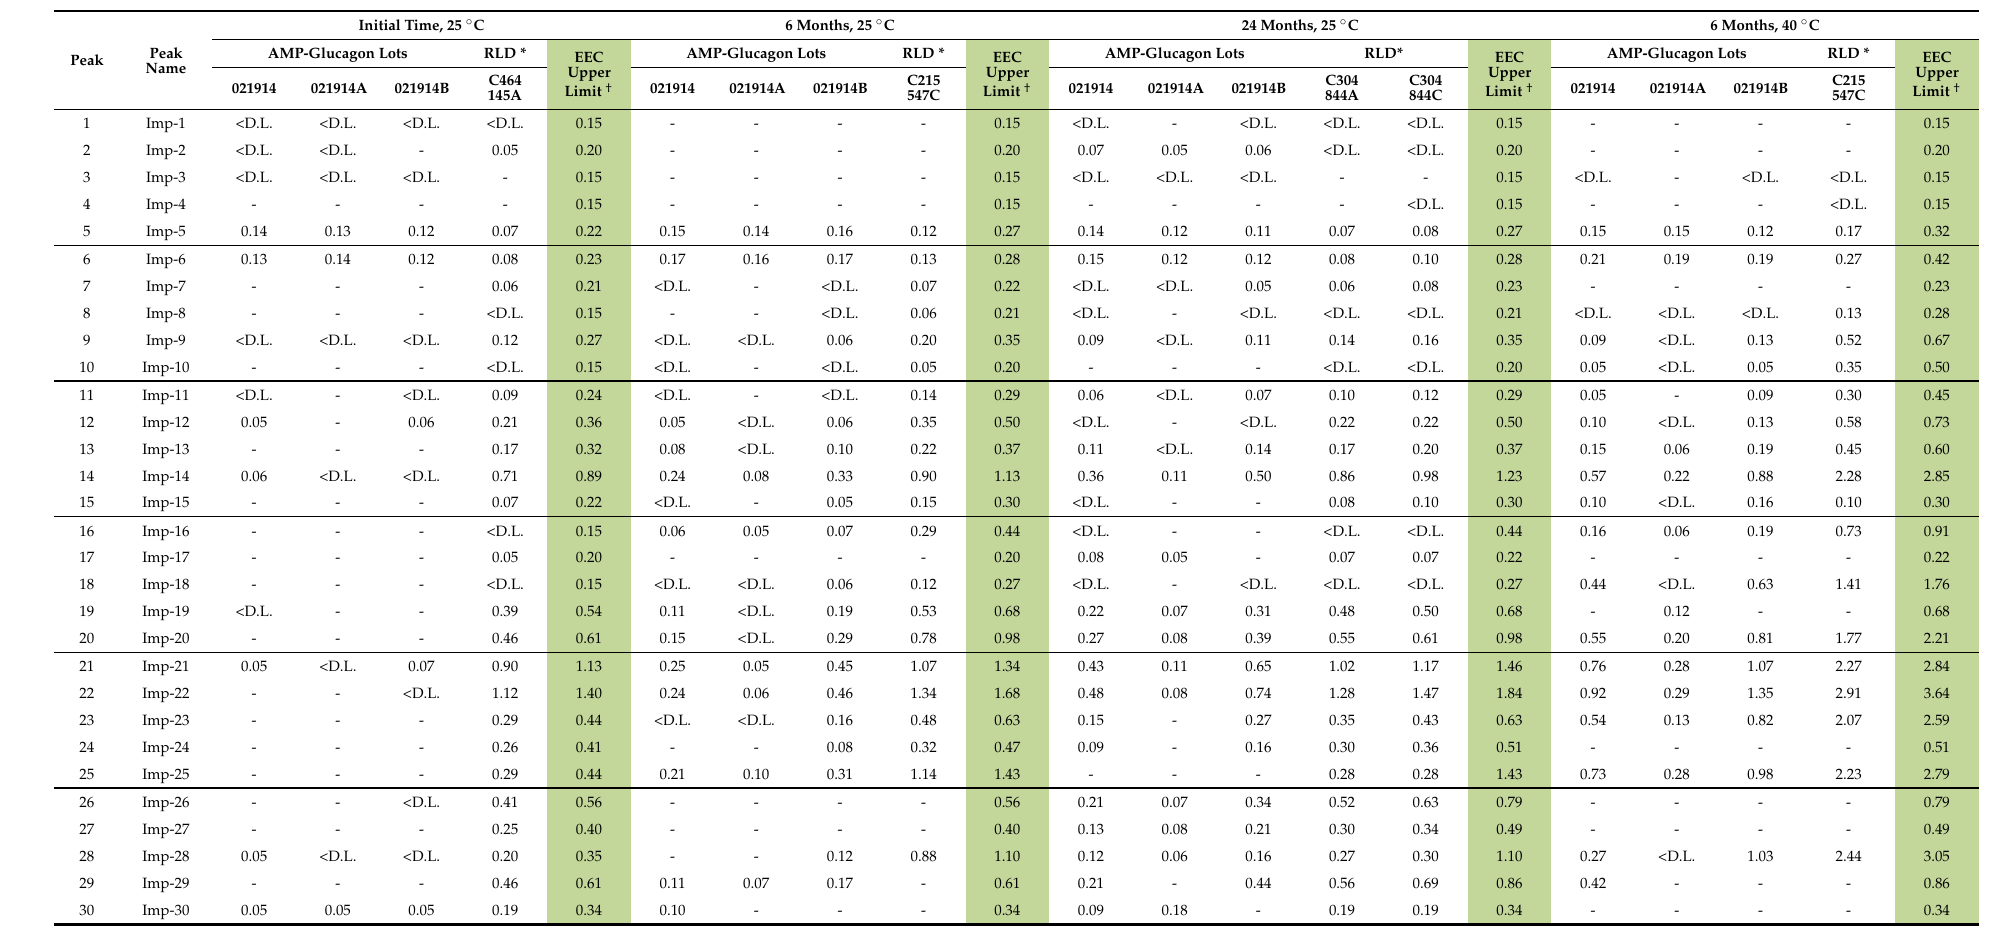
Table 3. Peak area percentage of glucagon and impurities at 25 ◦ C and 40 ◦